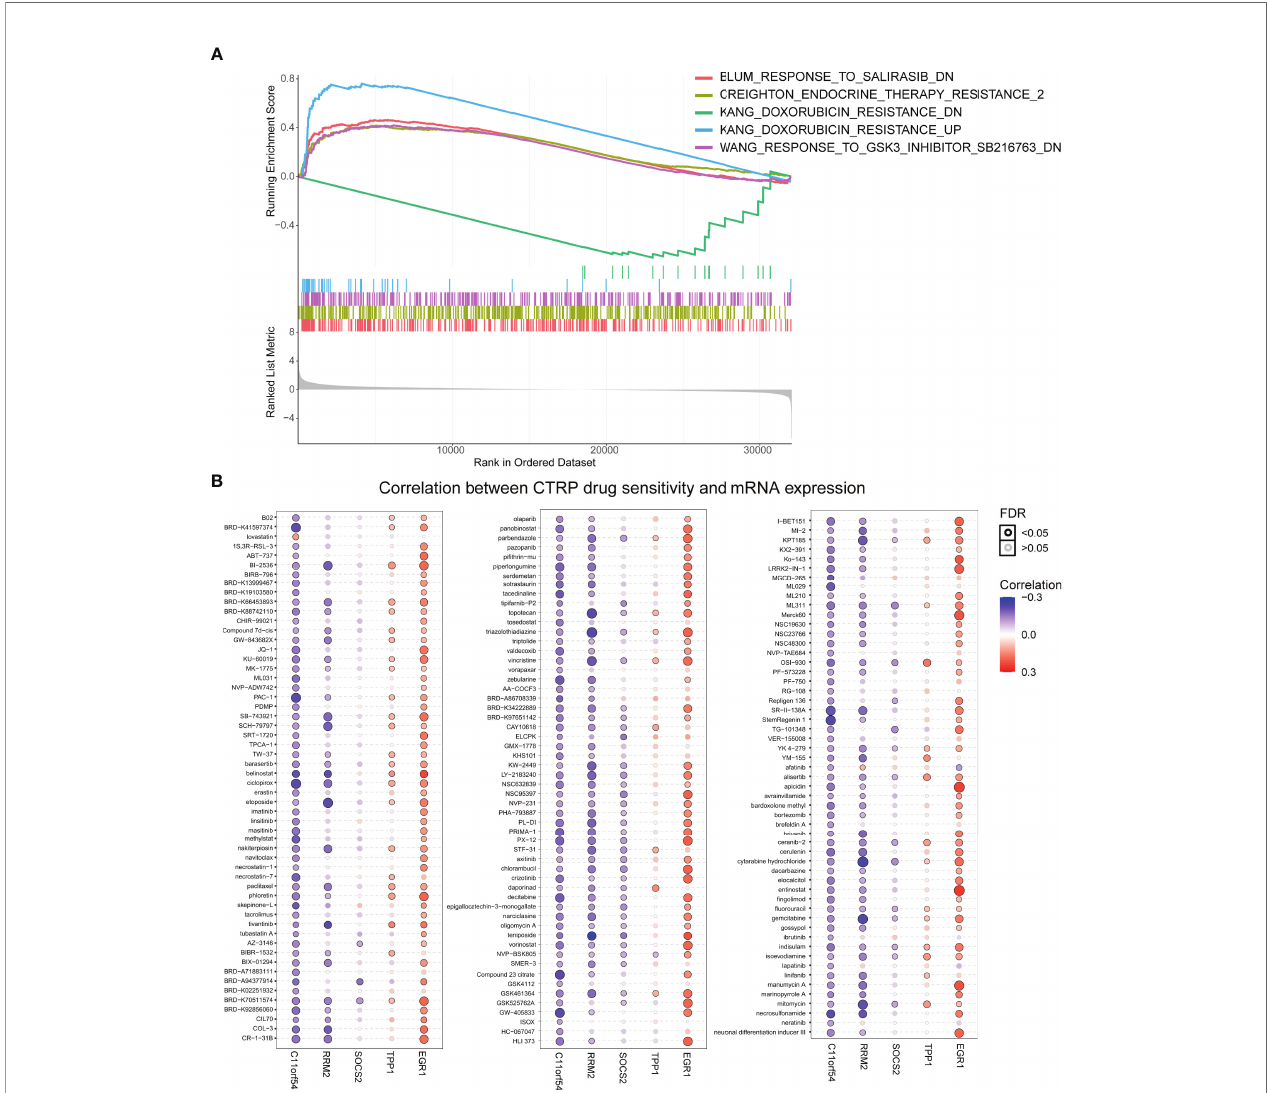
FIGURE 8 | The TILTregSig is a promising marker of cancer therapeutic resistance. (A) The relationship between the TILTregSig and therapeutic resistance using GSEA. (B) A landscape plot was generated to depict the relationships between the IC 50 data of different molecules and the fi ve genes ’ expression pro fi les in cancers using